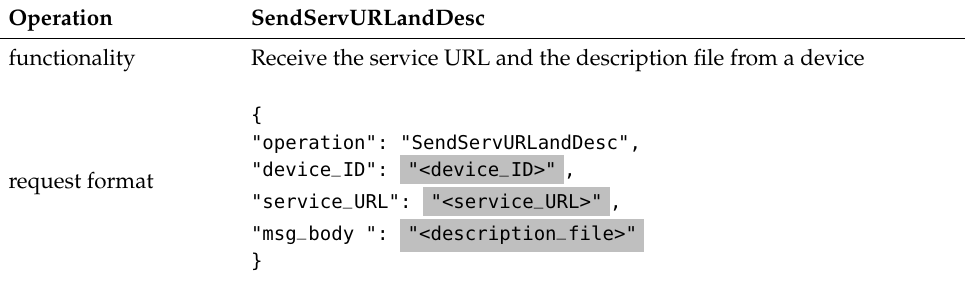
Table 7. SendServURLandDesc